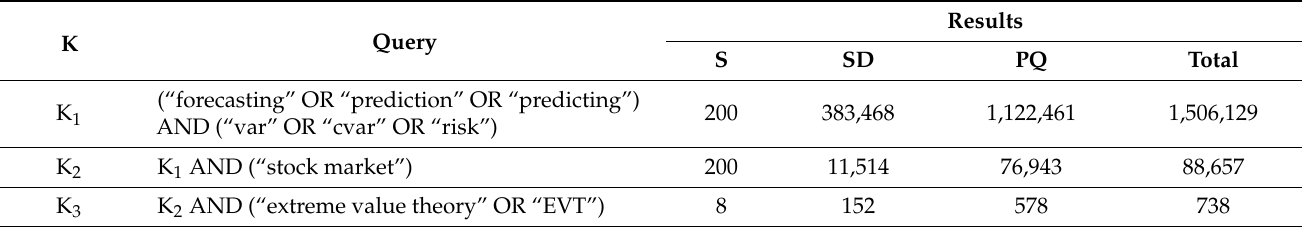
Table 4. Search results by keyword